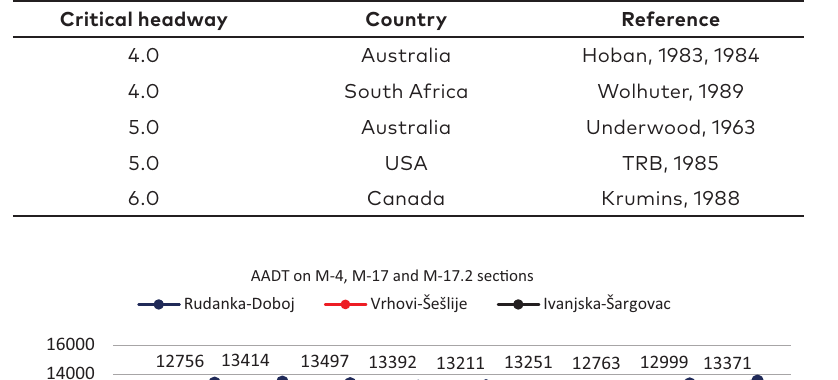
Table 4. Critical headways recommended by some authors